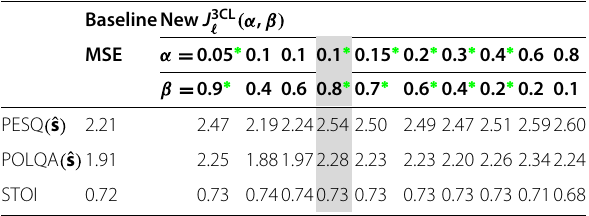
Table 3 Optimization of hyperparameters and for the new 3CL (11) on 12 . 5 % of the validation set . The selected setting is